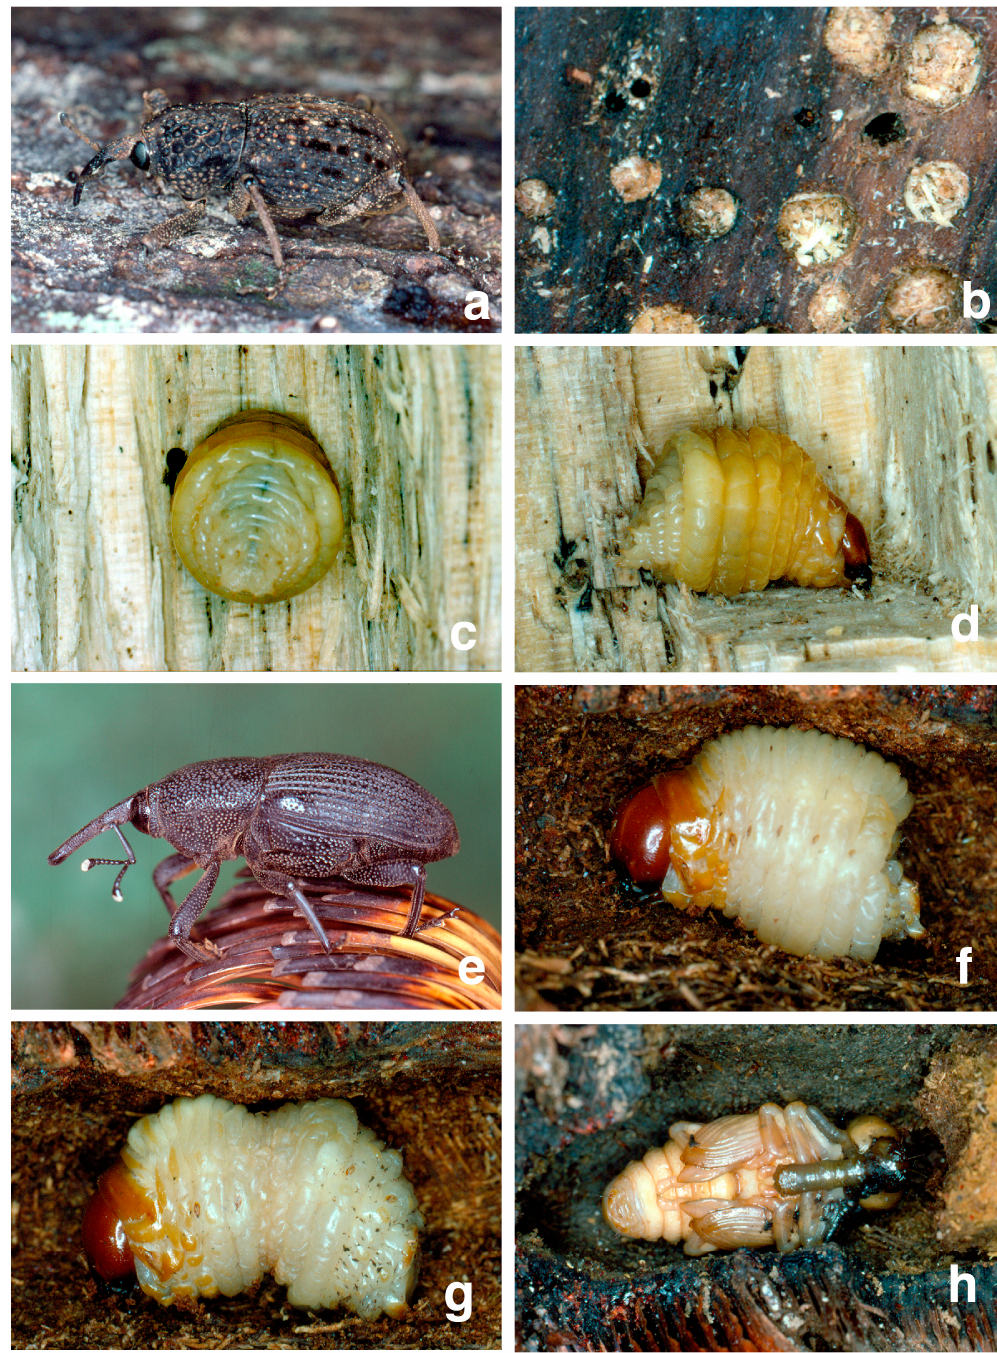
Figure 94. Sipalinus gigas. : ( a ) adult; ( b ) external damage; ( c ) larva, caudal view; ( d ) larva, lateral view; Trigonotarsus calandroides ( e ) adult, lateral view;: ( f ) larva, lateral view; ( g ) larva undergoing peristaltic behavior, lateral view; and ( h ) pupa, ventral view. Photographs courtesy of Rolf Oberprieler.